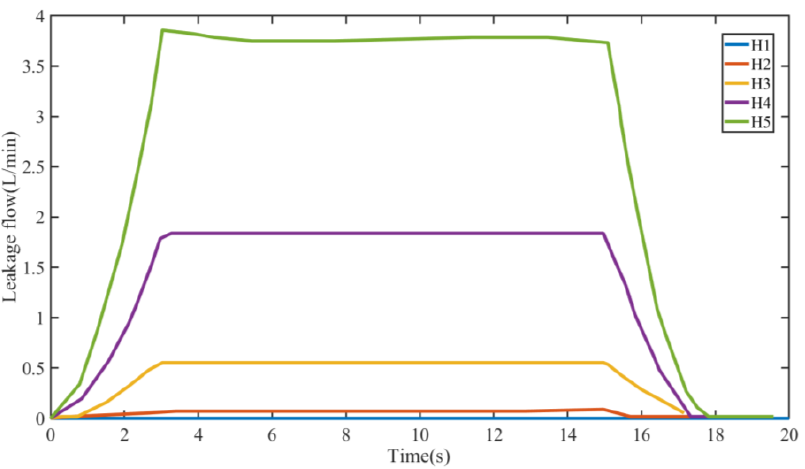
Figure 15. Leakage flow of leakage in reversing valve.